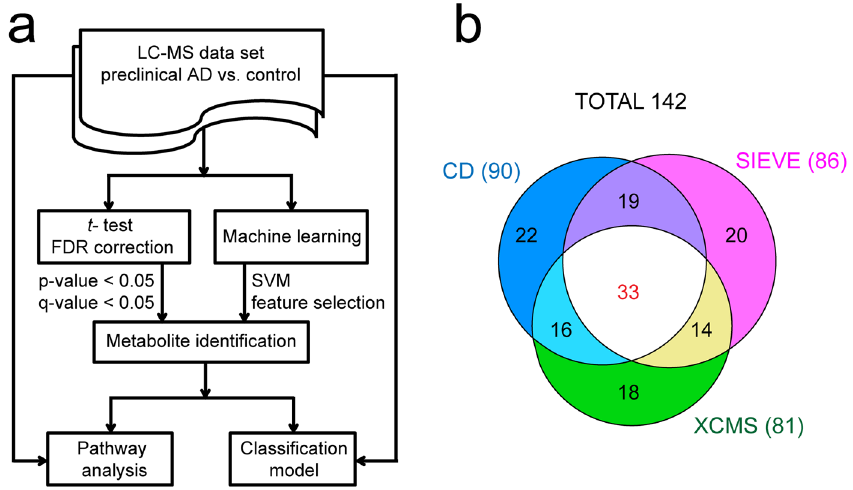
Figure 3. Data analysis flowchart ( a ) and the overlapping candidate biomarkers of preclinical AD resulted from three software packages ( b ).